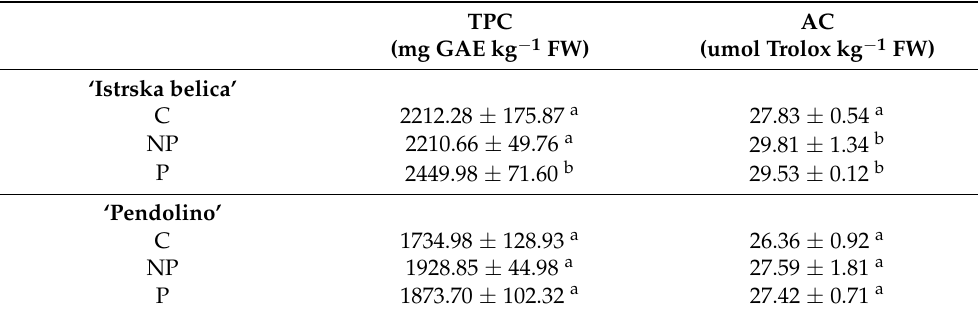
Table 2. Total phenolic content (mg GAE kg − 1 FW) and antioxidant capacity (umol Trolox kg − 1 FW) of control fruits, pierced and non-pierced tissue of damaged olive fruits of cultivars ‘Istrska belica’ and